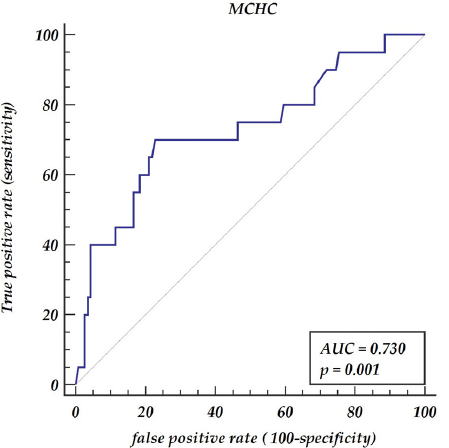
Figure 2. Receiver operator characteristic curve for mean corpuscular hemoglobin concentration (MCHC). Abbreviations: AUC—area under the curve, MCHC—mean corpuscular hemoglobin con- centration.